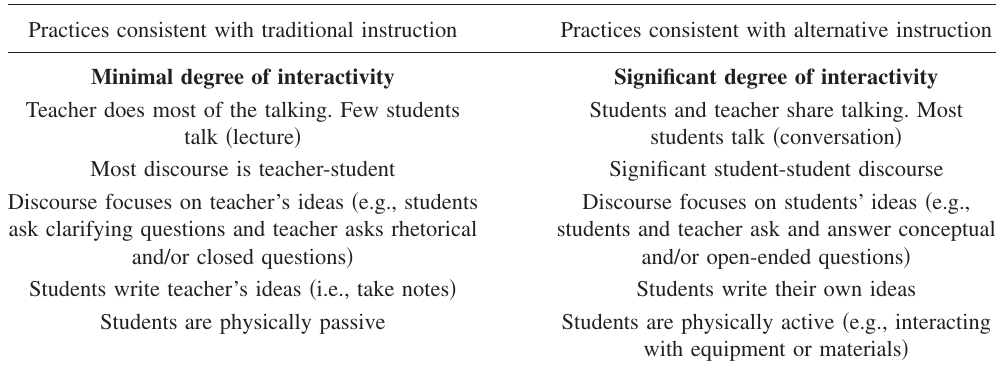
TABLE I. Interactivity category of the practices framework (cid:1) P1 (cid:2) . Practices consistent with traditional